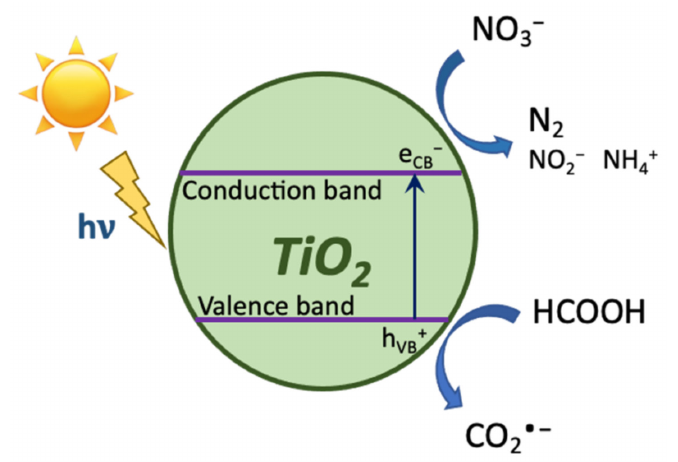
Figure 10. Nitrate photocatalytic reduction on TiO 2